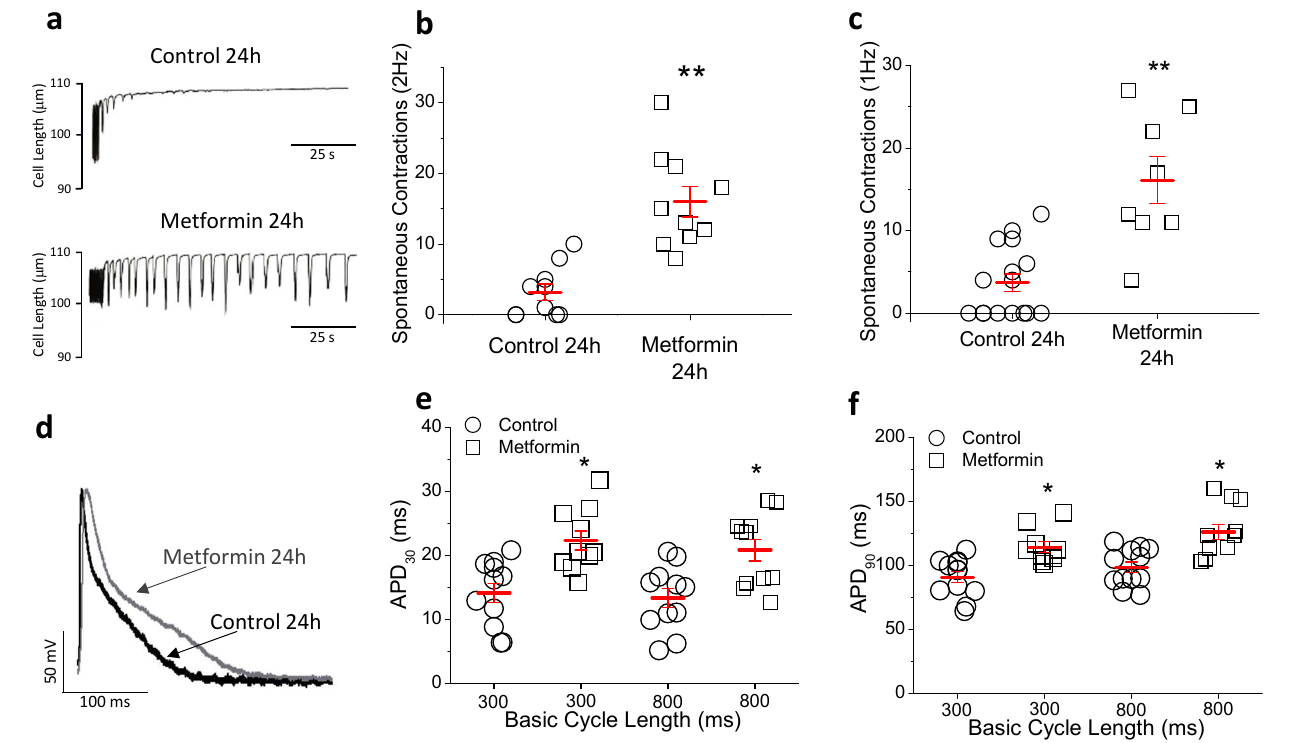
Figure 4. Metformin increases spontaneous contractions and prolongs AP duration in vitro. Car- diomyocytes isolated from control animals were incubated with 10 mM metformin or vehicle for 24 h. ( a ) Representative recordings of spontaneous contractions developed after interruption of a stimulation train at 2 Hz. Mean number of spontaneous contractions during the first 100 s after pacing interruption at stimulation trains of 2 Hz (n = 10 control and 10 metformin) ( b ) and 1 Hz (n = 15 control and 8 metformin) ( c ). Representative traces of AP ( d ) and AP duration at 30% (APD 30 ) and 90% of repolarization (APD 90 ) ( e , f ) of repolarization at stimulation frequencies of 300 and 800 ms (n = 11 control and 11 metformin). Points represent individual data with mean ± SEM (red marks), ** p < 0.01 and * p < 0.05 compared to control at the same